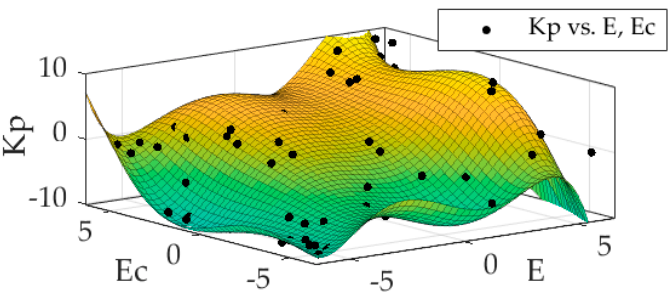
Figure 8. The fitting surface ∆ K p of the granular function.